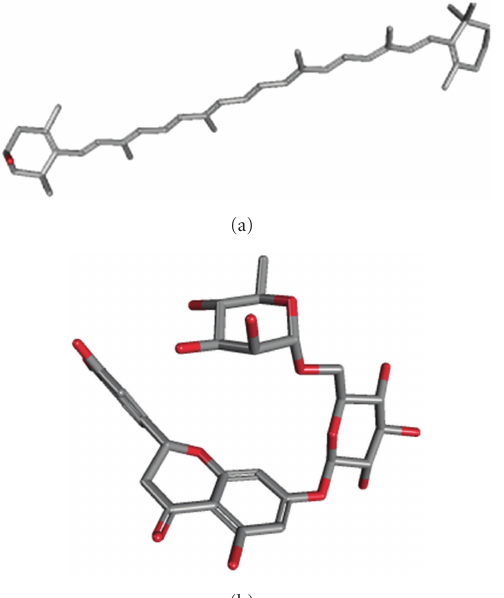
Figure 2: Dietary CHRP suppresses AOM-induced colonic aber- rant crypt foci (ACF) in